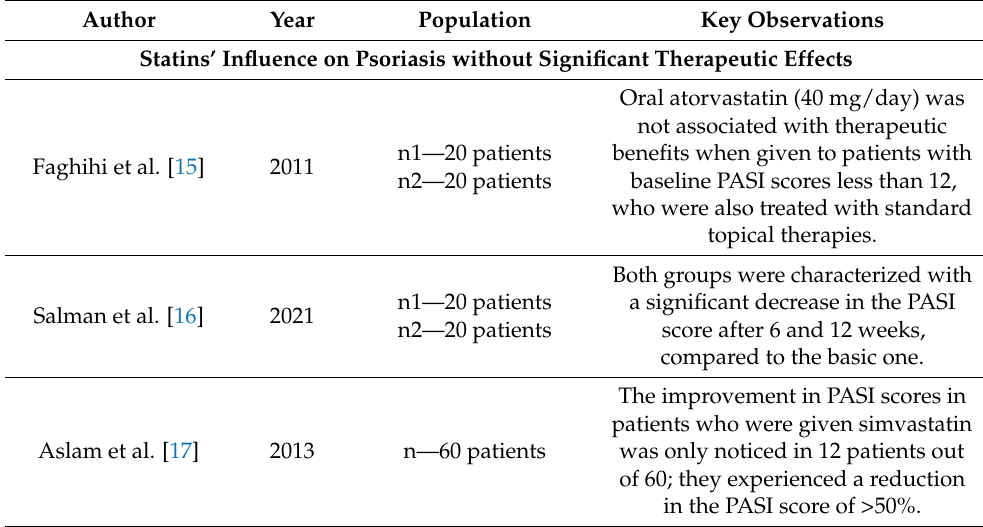
Table 4. Summary of the studies on statins’ influence on psoriasis without significant therapeutic